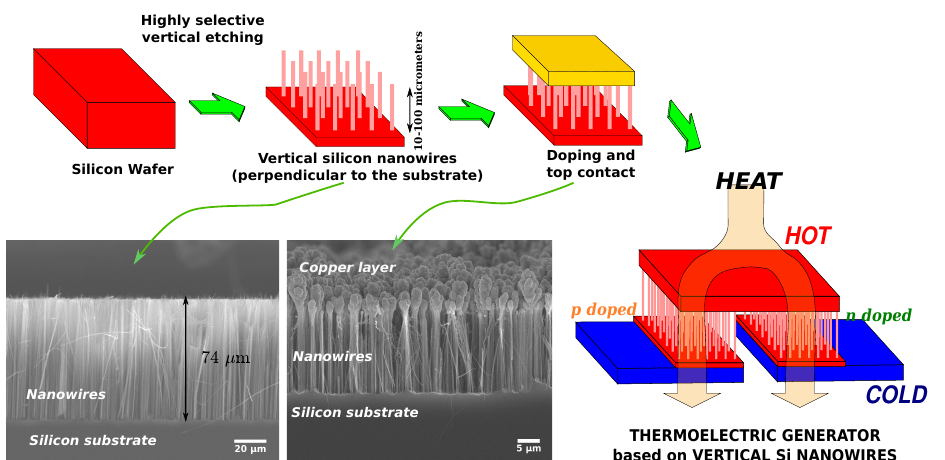
Figure 7. Sketches and SEM micrographs of thermoelectric devices based on silicon nanowires fabricated perpendicular to the